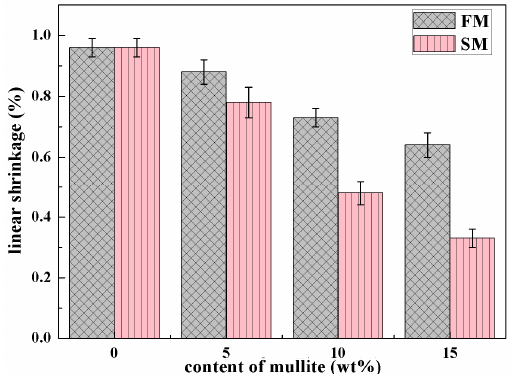
Figure 5. Linear shrinkage of ceramic cores with different contents of mullite.